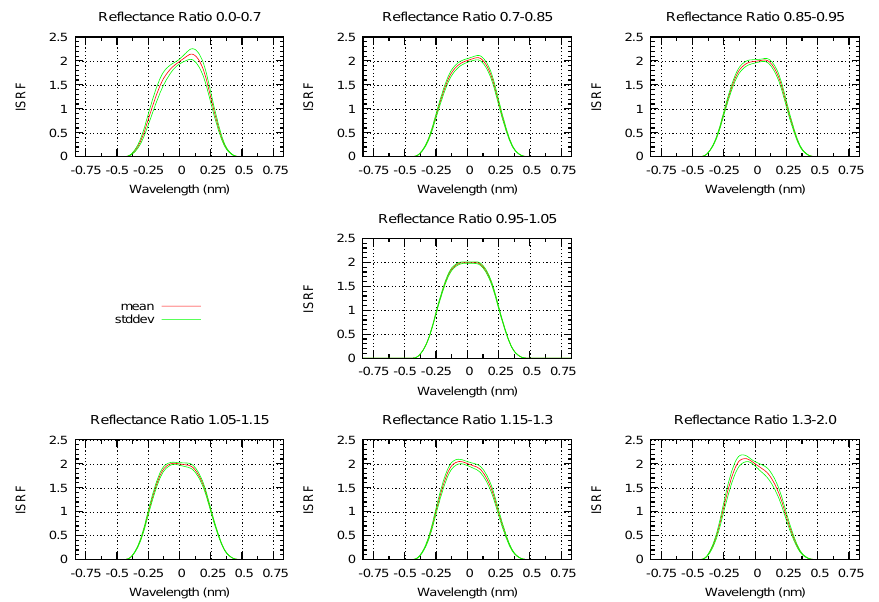
Fig. 4. Classification of inhomogeneous ISRFs. Red: mean ISRFs for the specified interval of reflectance ratios. Green: plus/minus corre- sponding standard